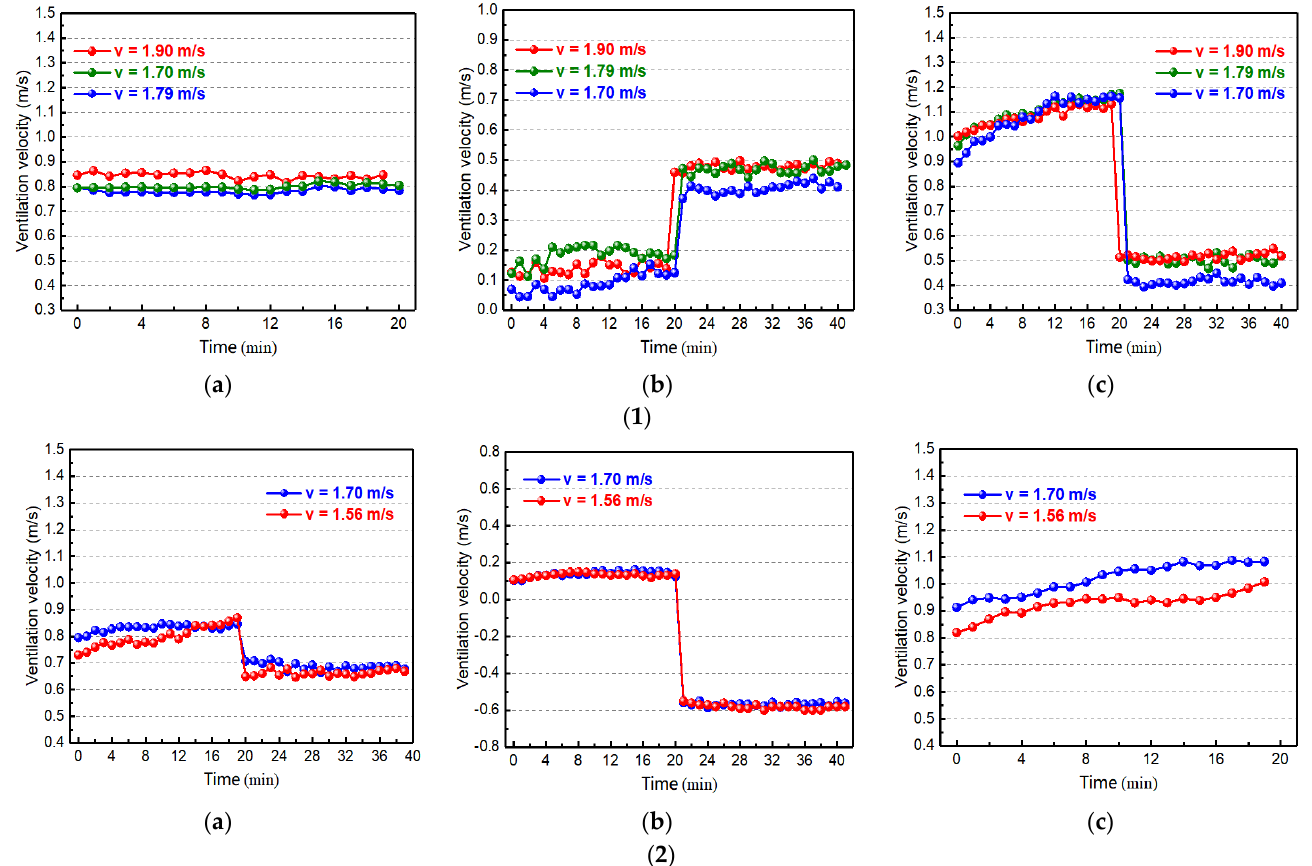
Figure 7. Wind velocity variation for different schemes: ( 1 ) Air-door 1 closed: ( a ) Branch 3. ( b ) Diagonal branch. ( c ) Branch 4. ( 2 ) Air-door 5 closed : ( a ) Branch 3. ( b ) Diagonal branch. ( c ) Branch 4.